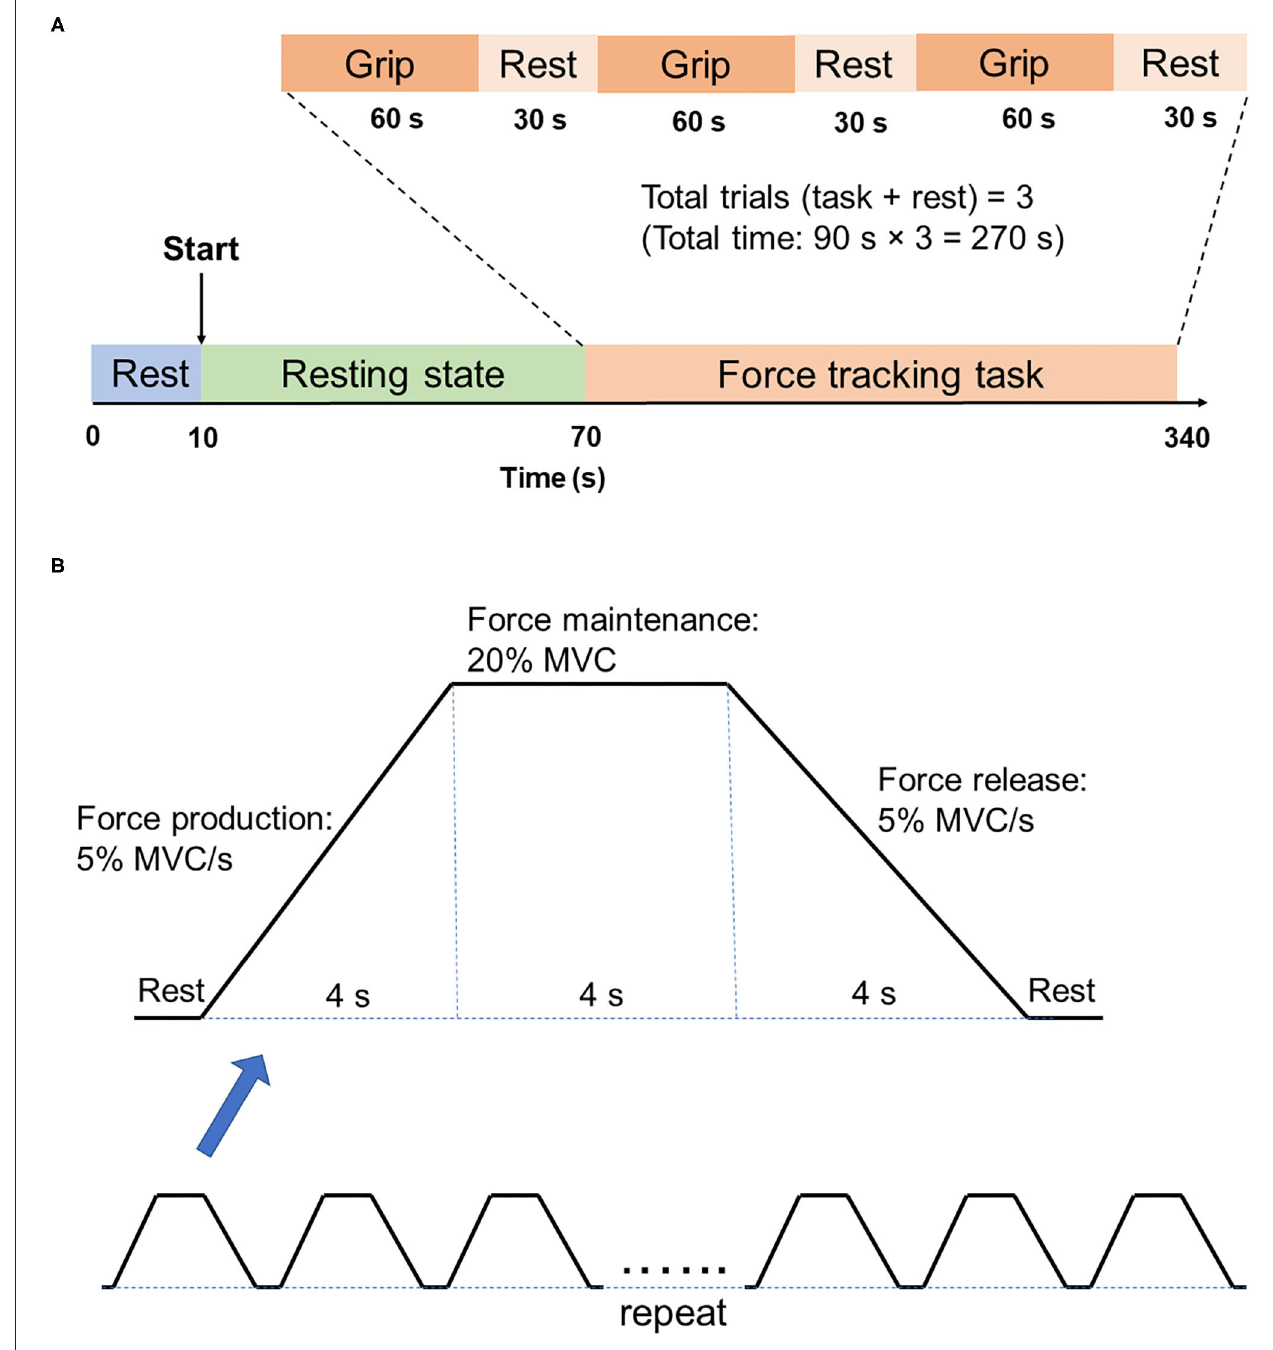
FIGURE 2 | Illustration of fNIRS testing. (A) fNIRS testing procedure. There are two states of fNIRS testing, which are the 60s resting state and 270s force tracking task. Force tracking task consists of three trials, with each trial followed by 30s rest. (B) Force tracking task paradigm. Each block of force tracking task includes force production phase, force maintenance phase and force release phase, with 4s rest break between two adjacent blocks.